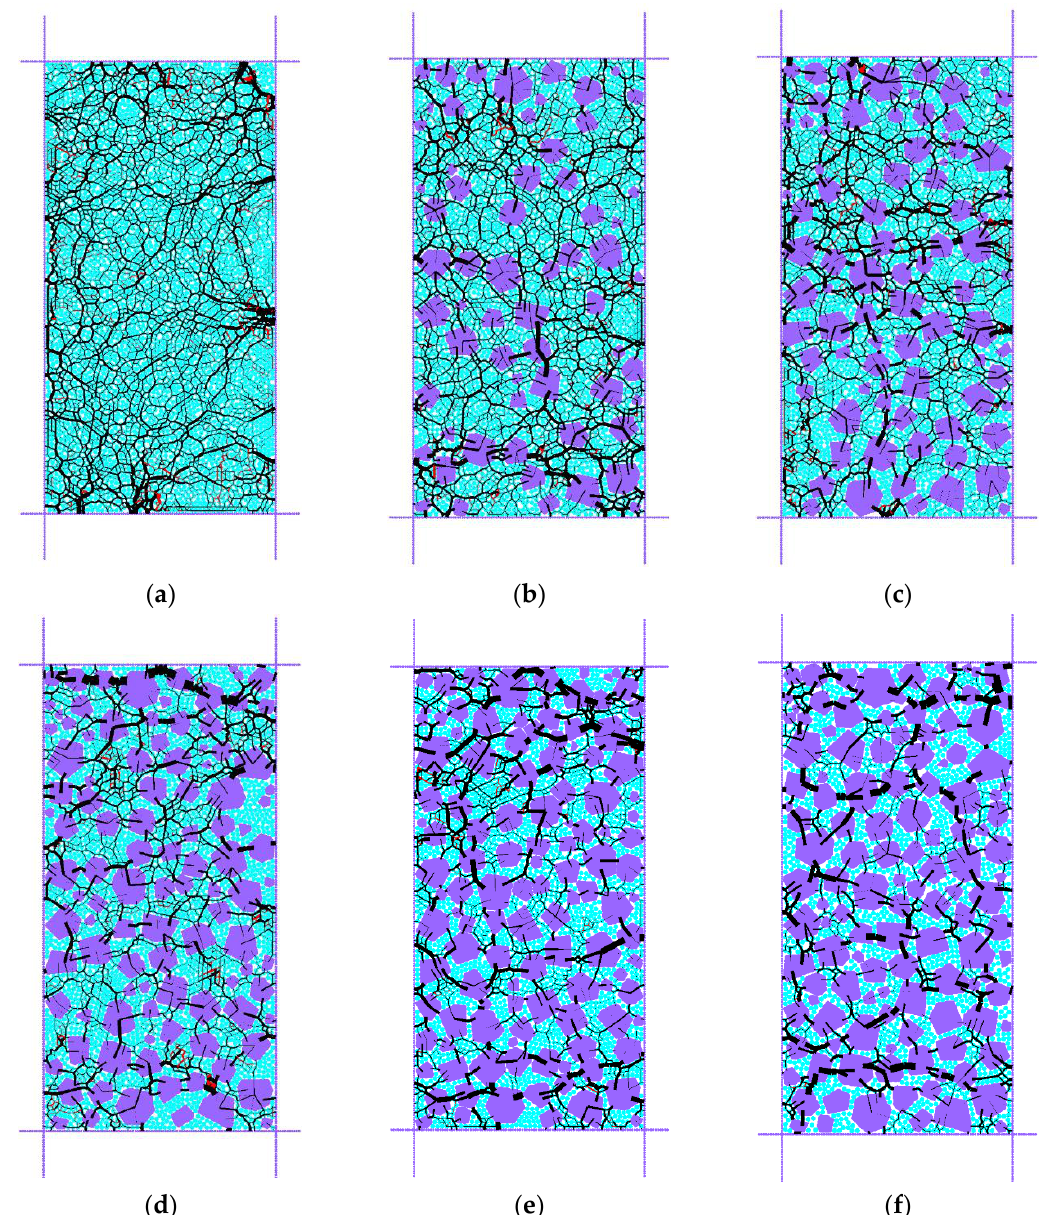
Figure 6. Contact-force distribution of DEM models at the 40kPa cell pressure with different R c : ( a ) 0%; ( b ) 30%; ( c ) 40%; ( d ) 50%; ( e ) 60%; ( f ) 70%. ( b ) 30%; ( c ) 40%; ( d ) 50%; ( e ) 60%; ( f )